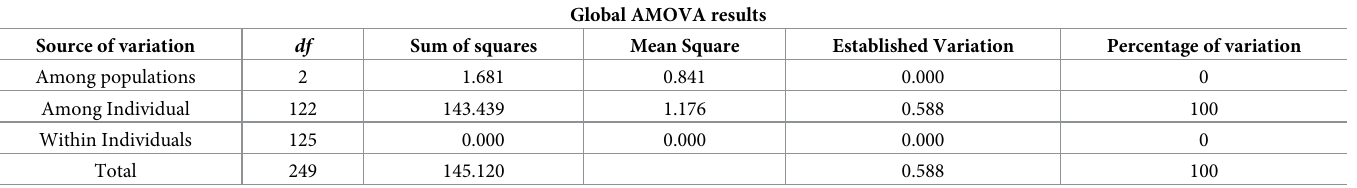
Table 4. Analysis of molecular variance of Pfs47 gene in P . falciparum population circulating in Homa Bay, Chulaimbo and Kombewa. Global AMOVA